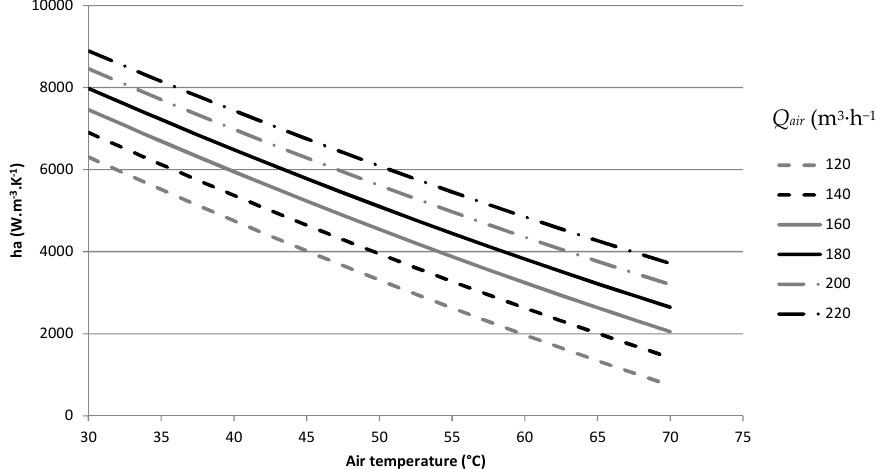
Figure 9. Best fitted convective heat transfer coefficient for different operating Figure.9. Best fitted convective heat transfer coefficient for different operating conditions. The coefficient linearly increased with the air mass flow rate and almost linearly decreased with the applied air temperature values. These results are in good agreement with the kinetic theory of gases (ideal gas). Indeed, the coefficient is often calculated using correlations (Nusselt number) in the general form; Nu = C ·Re  · Pr  with  >  > 0. The Reynolds number (Re) is linearly proportional to the fluid velocity that explains the increase of the coefficient with the air mass flow rate. According to the kinetic theory of gases for an ideal gas, the dependence in temperature of the convective  coefficient is   . Starting from these equations for kinetic and heat transfer, the program can be used in a predictive way. To evaluate the predictive capacity of the numerical tool, the model was validated by comparing experimental and numerical temperature profiles (in the middle of the biomass bed). Figures 10 and 11 show the calculated temperature profiles compared to the four experimental profiles obtained with the operating conditions of test 5 and test 6, respectively. Figure 10. Experimental and simulated temperature profiles during the drying test five in the center of the biomass bed.